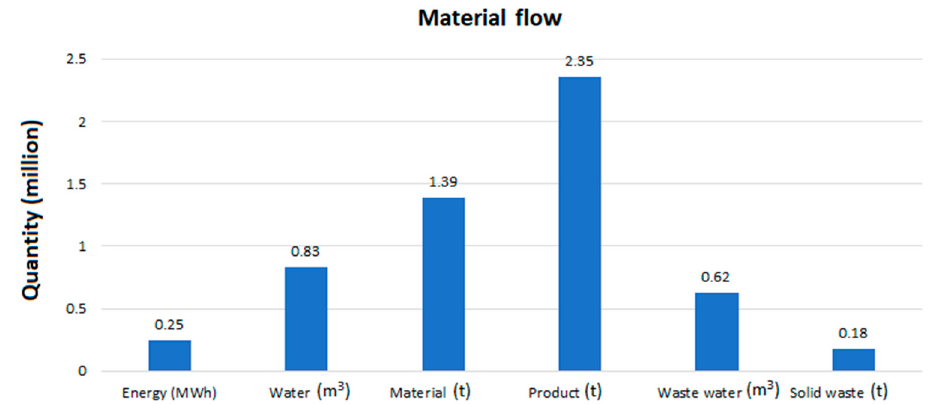
Figure 2. Life cycle assessment of symbiotic environment in Sodankylä.